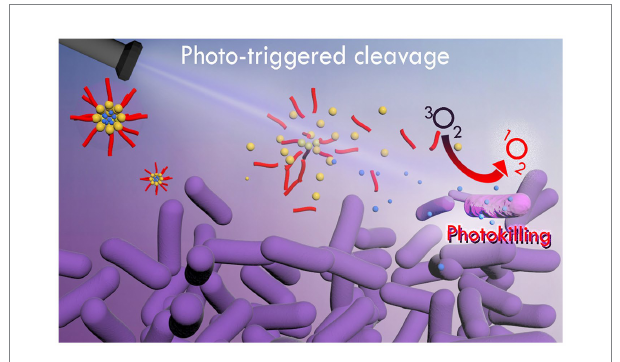
FIGURE 1 Schematic representation of photo-release of CUR from photo- responsive micelles for photoinactivation of bacterial